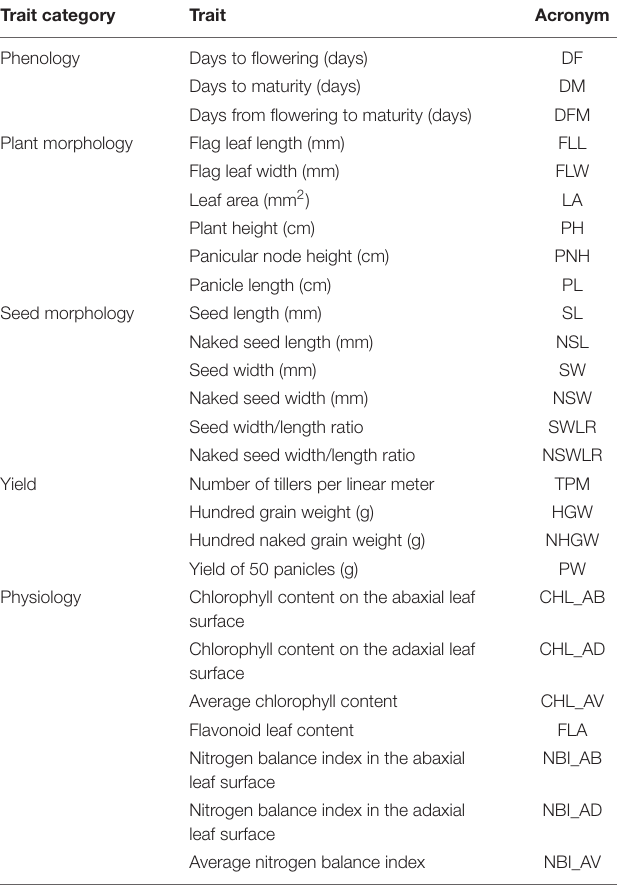
TABLE 1 | List of the measured traits and related units. Trait category Trait